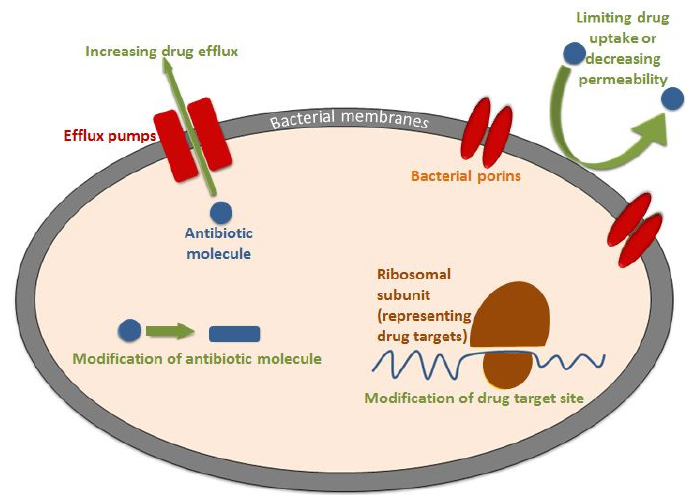
Figure 2. Mechanisms of antimicrobial resistance in bacterial cells.